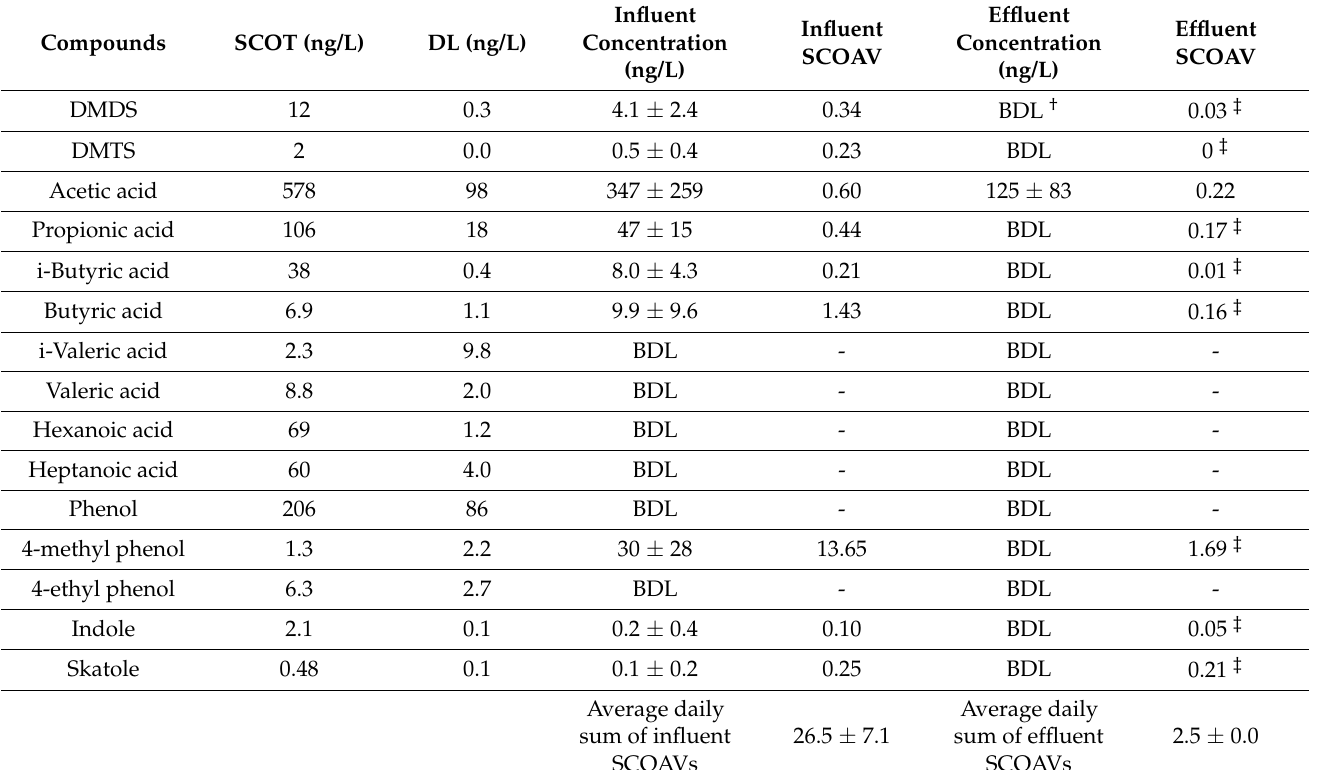
Table 3. Average influent and effluent concentrations of odorous volatile organic compounds and corresponding SCOAVs for 21 days ( n = 15) of operation.